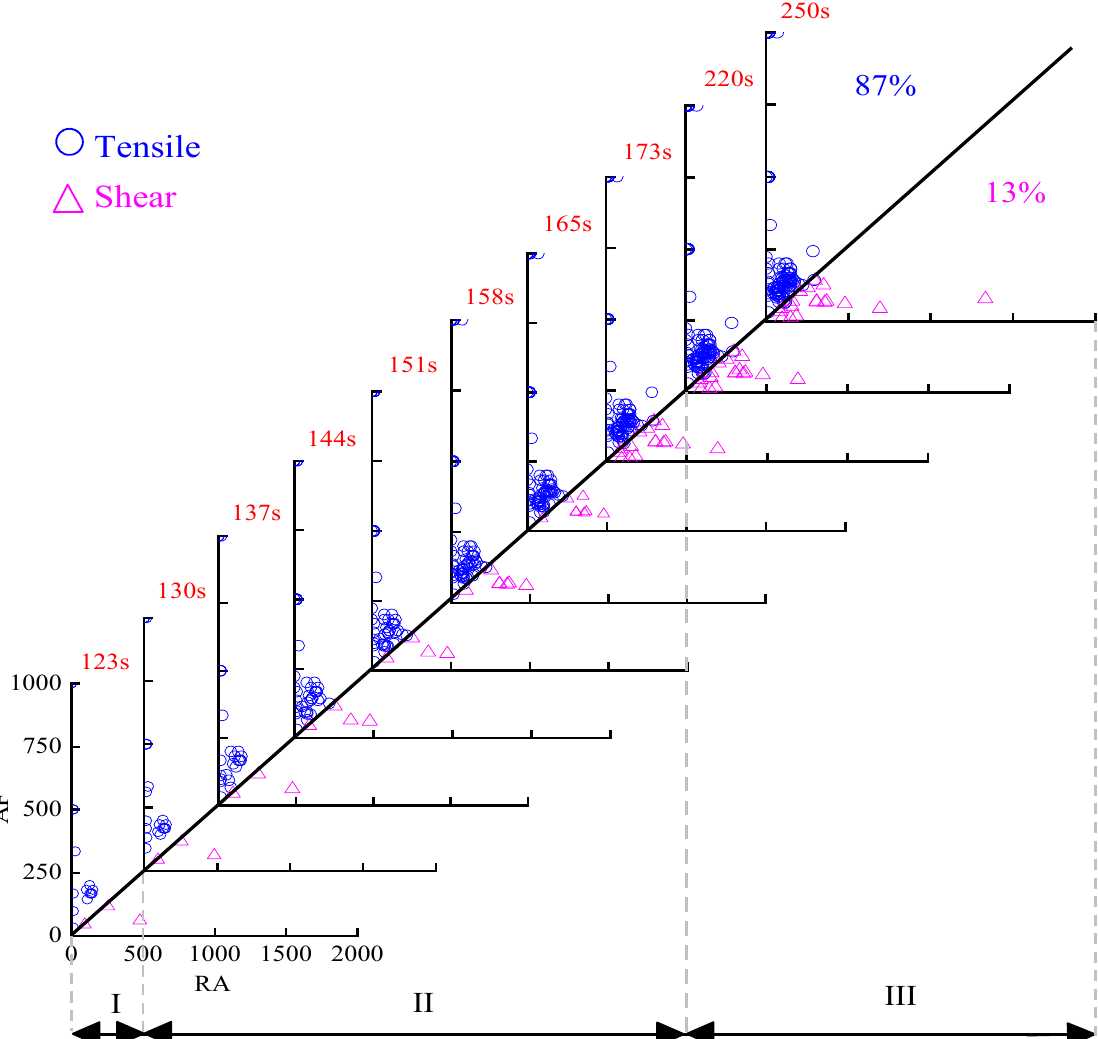
Figure 12. RA and AF distribution of OAC.